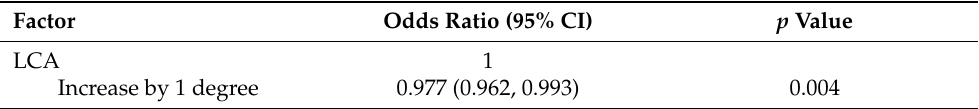
Table 8. Cont. Factor Odds Ratio (95% CI) p Value LCA 1 Increase by 1 degree 0.977 (0.962,